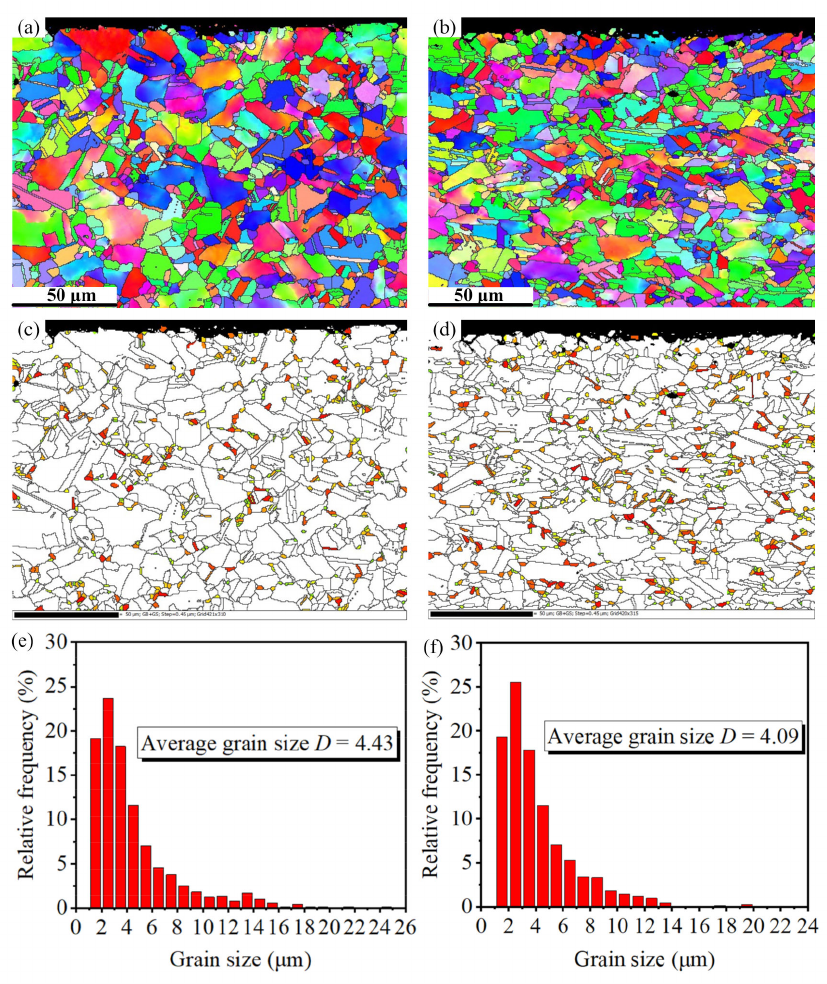
Figure 6. Grain size distribution after: ( a , c , e ) the FT process; ( b , d , f ) LPB processes. One reason for the grain refinement is due to the occurrence of dynamic recrystalliza- tion (DRX). Dehmas et al. [29] demonstrated that the temperature at which DRX